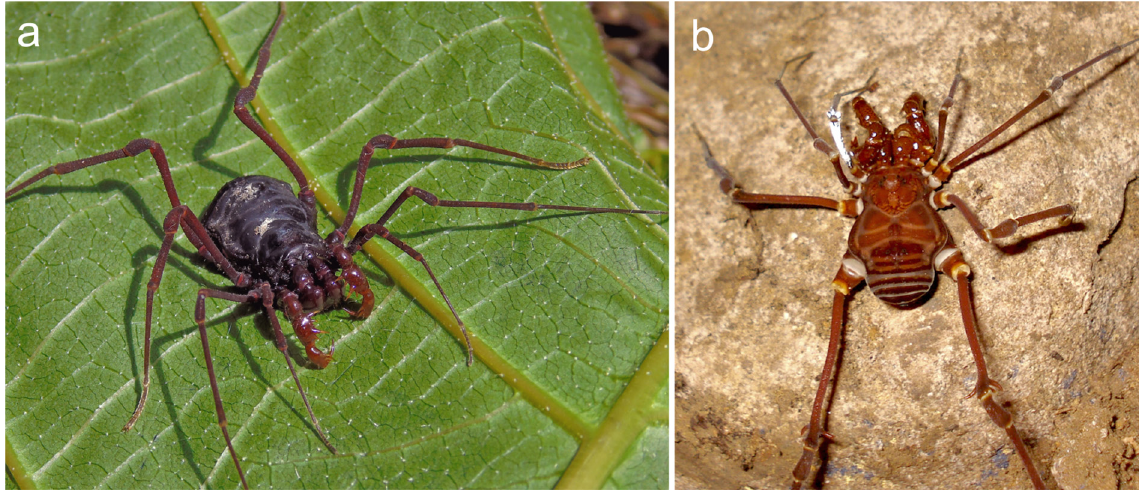
Fig. 19. Photographs of living specimens. a . Phalangodus anacosmetus Gervais, 1842, ♀. b . Phalangodus briareos sp. nov., ♂. Courtesy of S. Galvis (a) and J. Uribe